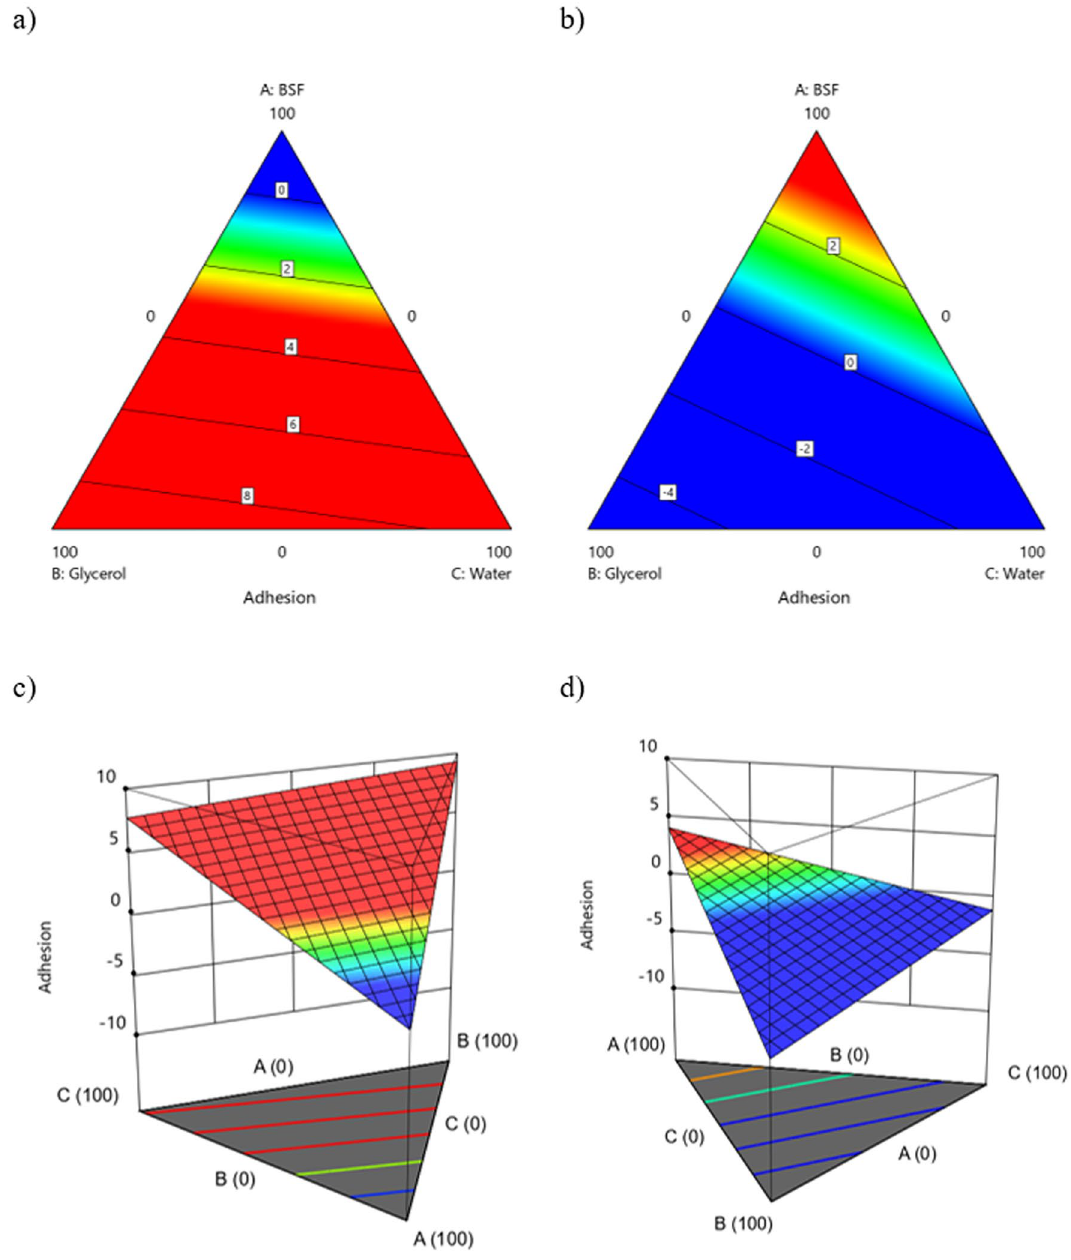
Figure 6. Contour plots for the response Adhesion ( a ) S1-2D; ( b ) S2-2D; ( c ) S1-3D; ( d )